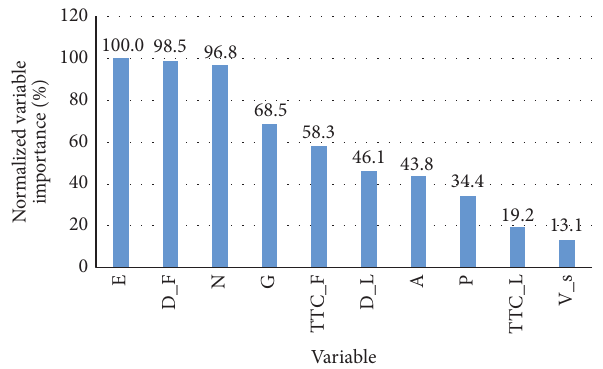
Figure 7: Ranked importance of the independent variables in the maneuver decision